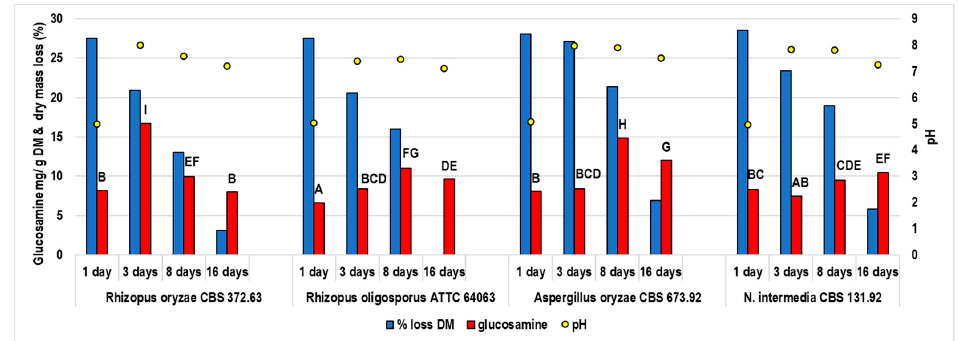
Figure 1. The concentration of glucosamine, dry matter loss, and pH during the fermentation of moringa leaves.